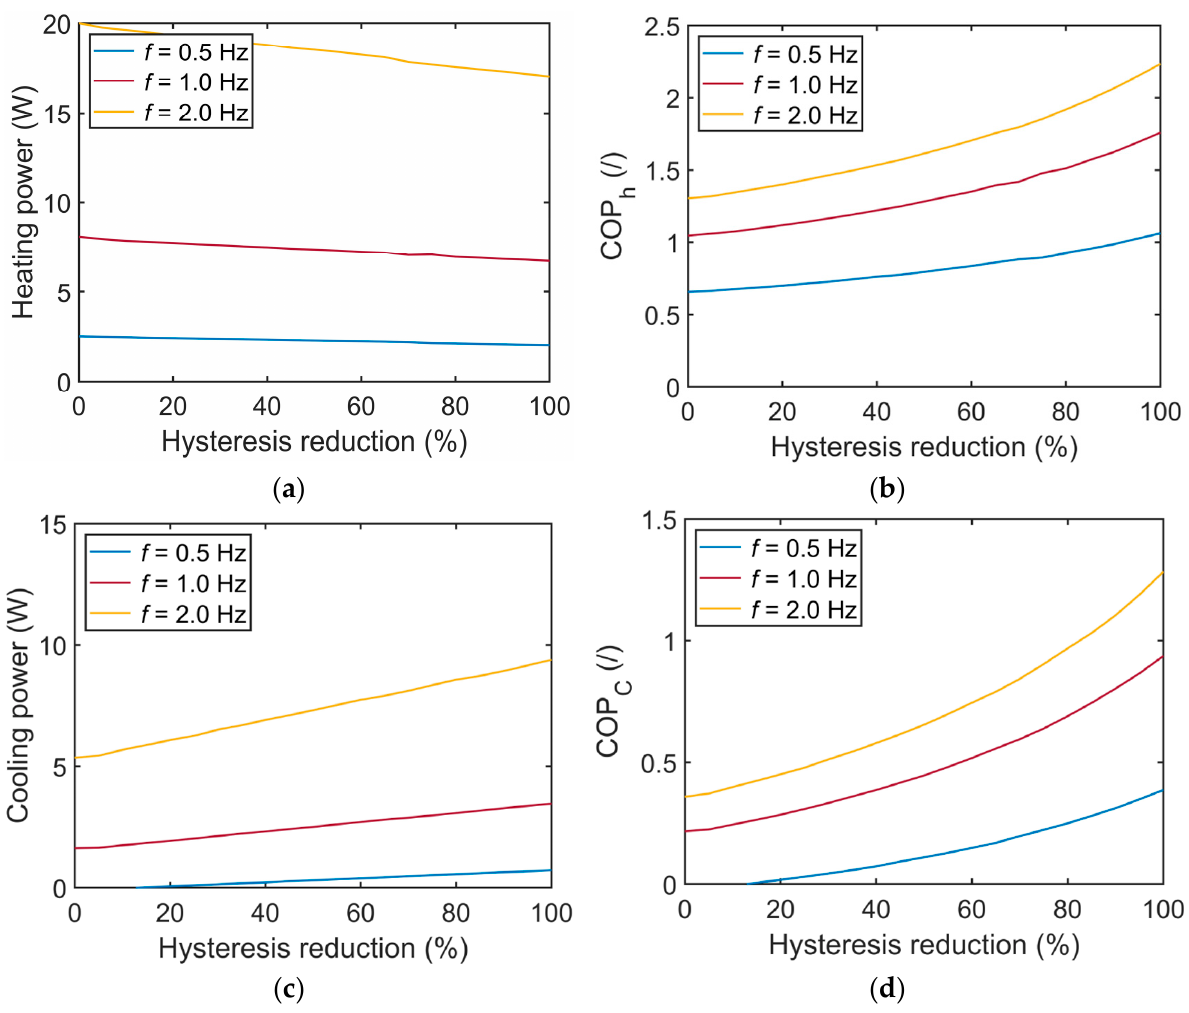
Figure 13. The effect of reduced hysteresis losses on the performance of the AeCR at a fixed strain of 2.7%, temperature span of 15 K and displaced fluid volume ratio of 0.6 for heat-pumping ( a , b ) and cooling ( c , d ).